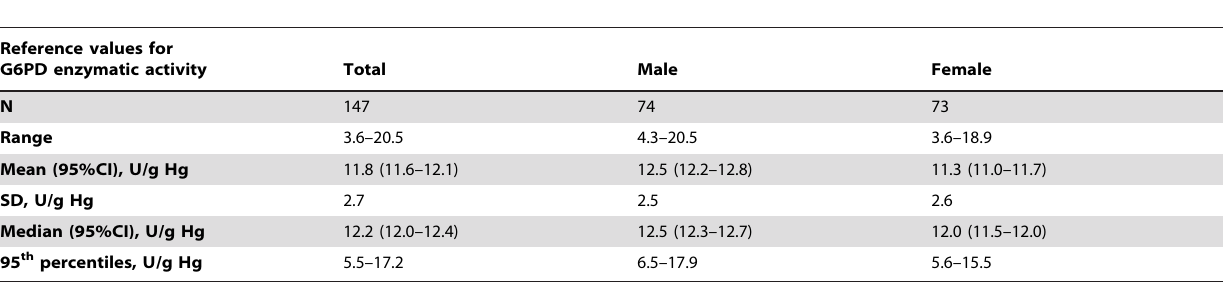
Table 2. Reference values for G6PD enzymatic activity (U/g Hg), Pailin province, Cambodia, 2010.